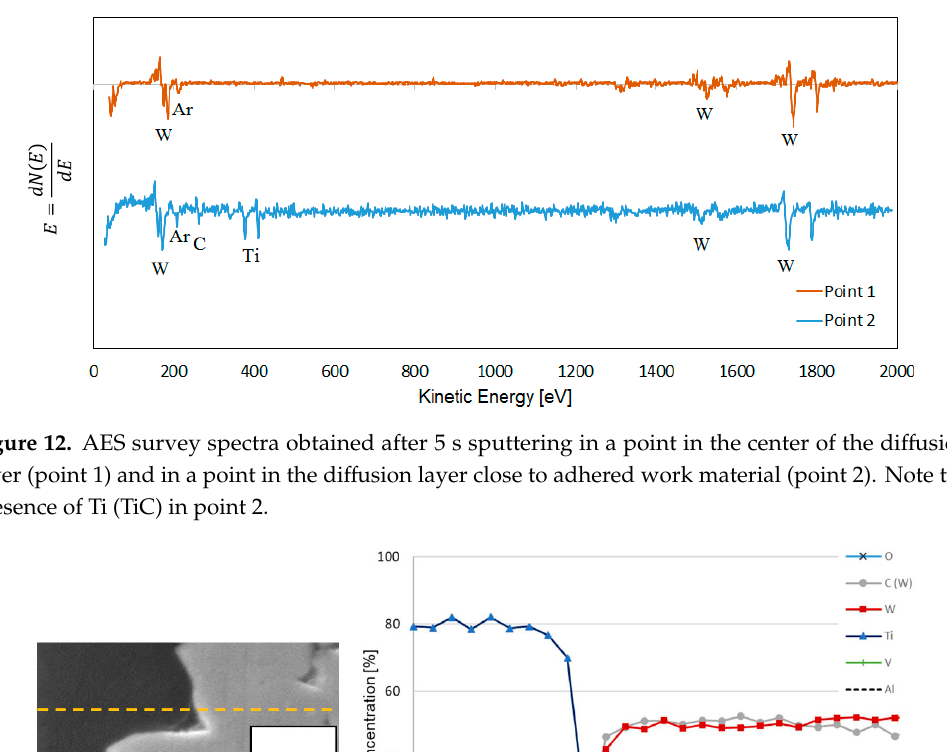
Figure 11. ( a ) Cross section of the rake face after 30 s turning Ti-6Al-4V at cutting speed of 90 m/min and feed rate of 0.2 mm/rev, ( b ) AES line scan obtained in the indicated line across the adhered work material–cemented carbide interface in the center of the crater wear region.